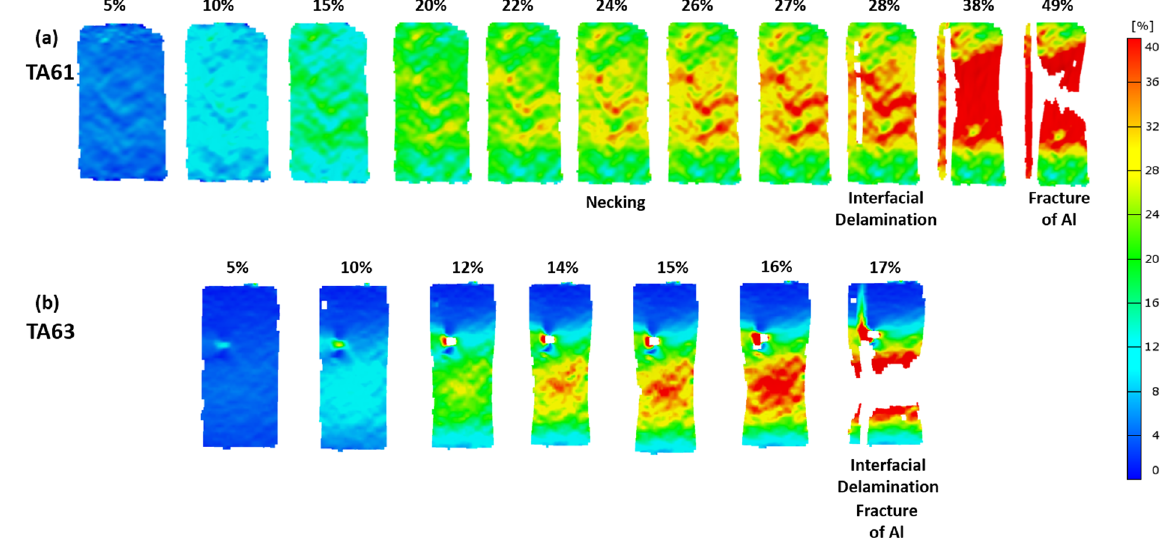
Figure 8. Digital images of strain distribution taken during tensile tests. Digital images of the ( a ) TA61, ( b ) TA63 specimens. Strains at the necking, cracking, and interfacial delamination points are described above each digital